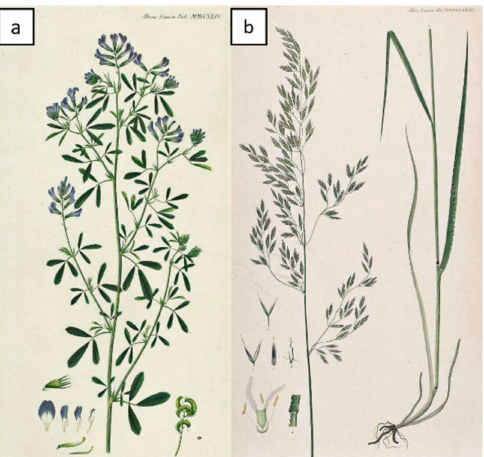
Generic illustration of the two forages described in this manuscript—( a ) Alfalfa